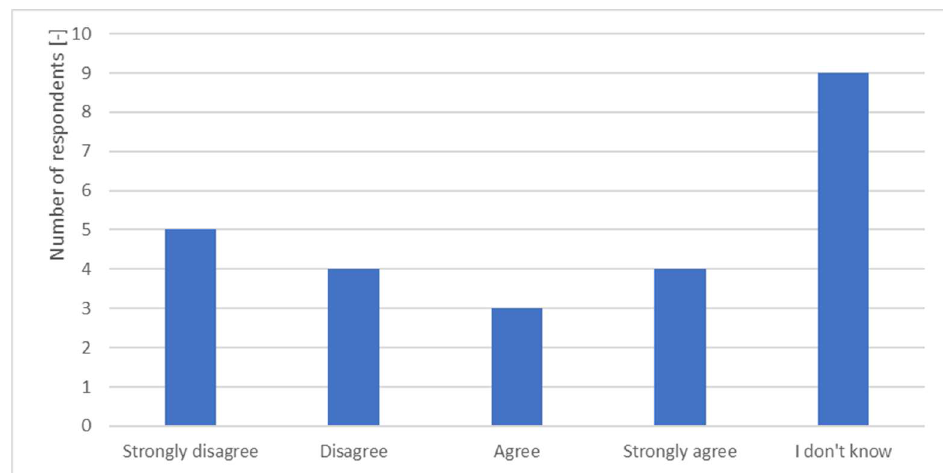
Figure 18. The impact of open innovation on the sale of services.